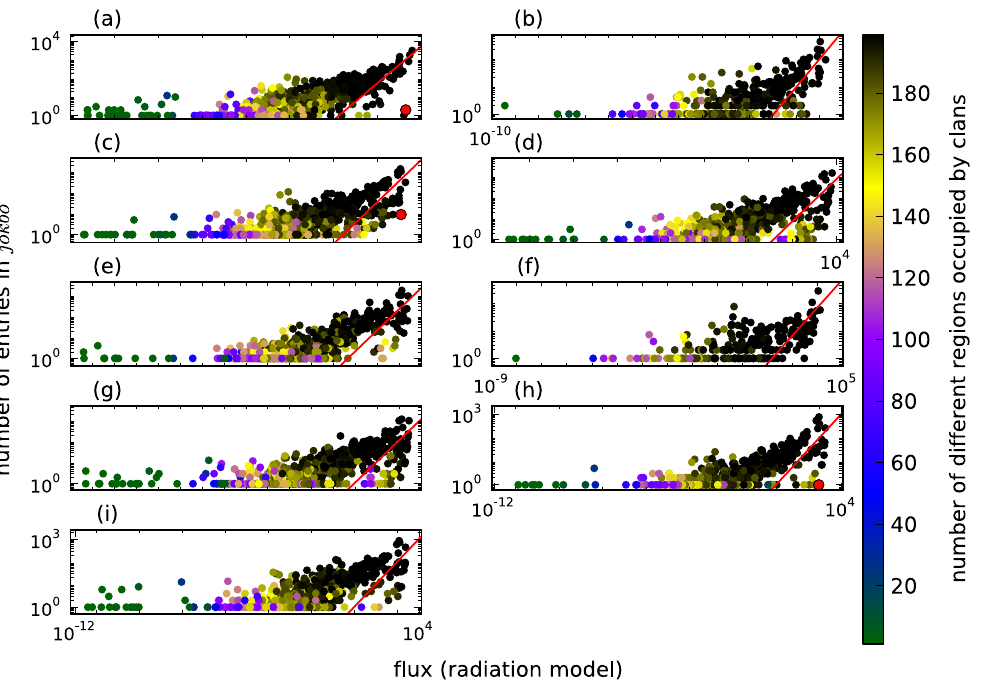
FIG. 7. Scatter plots of the number of clan entries in jokbo 2 – 10 versus the corresponding centroid in 2000 using the radiation-model flux. We show our results in numerical order of the jokbo in panels (a) – (i), so jokbo 2 is in panel (a), etc. In each panel, we calculate the a R line using a linear regression to determine the fitting parameter a for N , where R is the radiation-model flux of women from R i ¼ R ij ij ≈ 0 . 062 ð 2 Þ [ jokbo 2], clan i to clan j and N is the total number of entries from clan i in the jokbo . The parameter values are (a) a i R ≈ 0 . 0098 ð 7 Þ [ jokbo 3], (c) a ≈ 0 . 040 ð 3 Þ [ jokbo 4], (d) a ≈ 0 . 075 ð 7 Þ [ jokbo 5], (e) a ≈ 0 . 23 ð 2 Þ [ jokbo 6], (f) a ≈ 0 . 0069 ð 5 Þ (b) a R R R R R ≈ 0 . 12 ð 1 Þ [ jokbo 8], (h) a ≈ 0 . 11 ð 1 Þ [ jokbo 9], and (i) a ≈ 0 . 11 ð 1 Þ [ jokbo 10]. The red markers in panels (a), (c), and [ jokbo 7], (g) a R R R 0 for all of the other jokbo . In each case, we use a 95% confidence (h) correspond to the clans of the depicted jokbo , and N i j i ¼ j ¼ ownclan ¼ interval and color the points according to the number of administrative regions occupied by the corresponding clans.